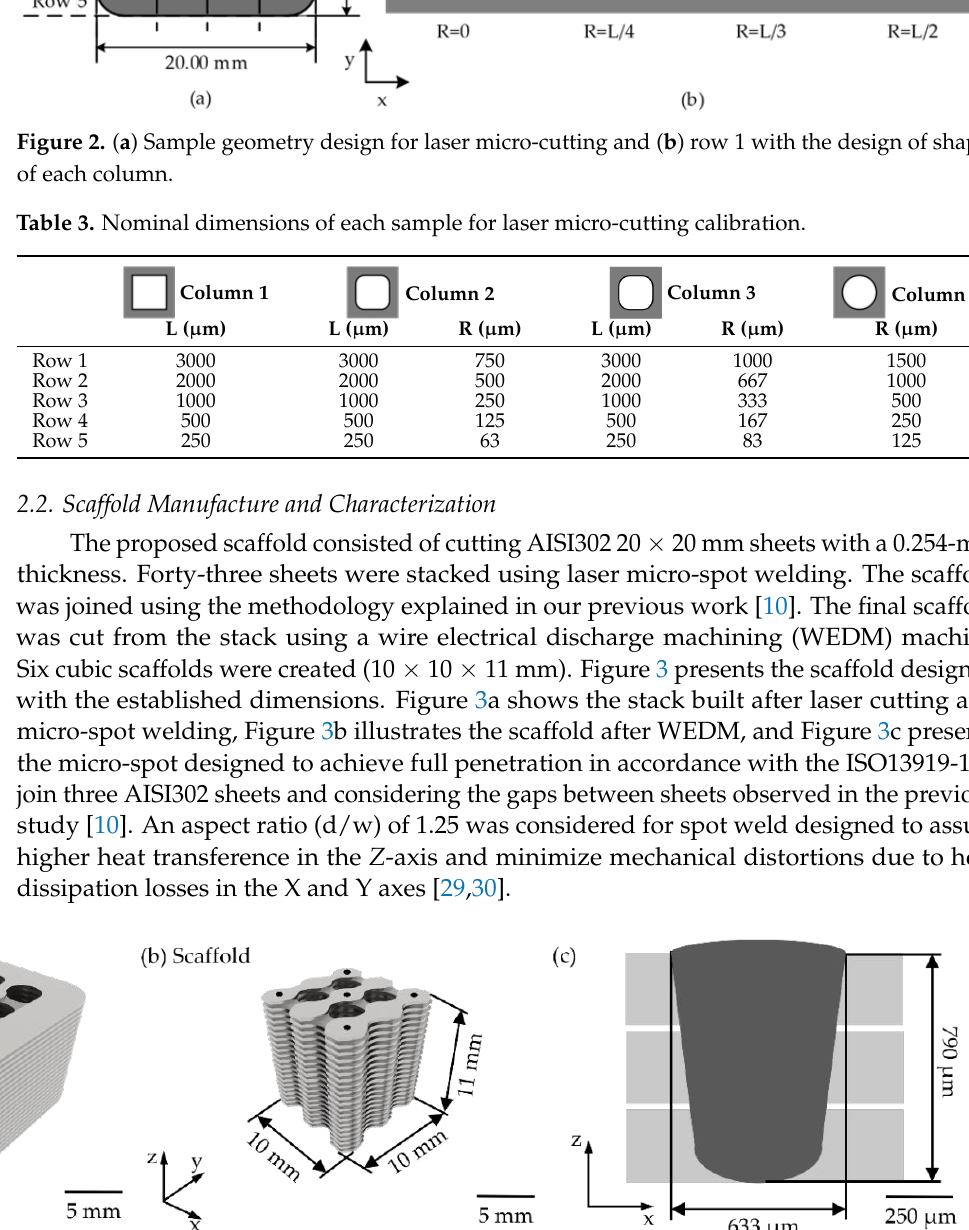
Figure 3. Designed scaffold ( a ) stack, ( b ) scaffold, and ( c ) laser micro-spot weld design .